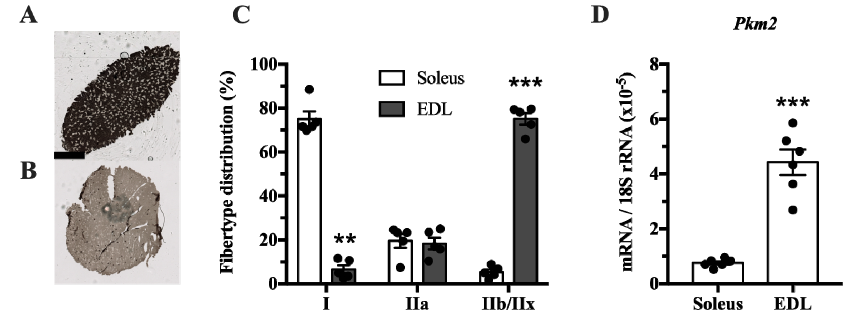
Figure 1. Pkm2 expression is highest in extensor digitorum longus (EDL) rat muscle that predominantly consists of type 2 fibers. ( A , B ) ATPase staining of ( A ) soleus and ( B ) EDL rat muscle to determine fiber types ( n = 4). ( C ) Fiber type distribution of rat soleus and EDL muscle. ( D ) Pkm2 mRNA expression in rat soleus and EDL ( n = 6). Black circles indicate individual data points. * Significantly di ff erent from control, unpaired t -test and Mann–Whitney U test ( p < 0.05); ** ( p < 0.01); *** ( p < 0.001). Scale bar in A indicates 1000 µ